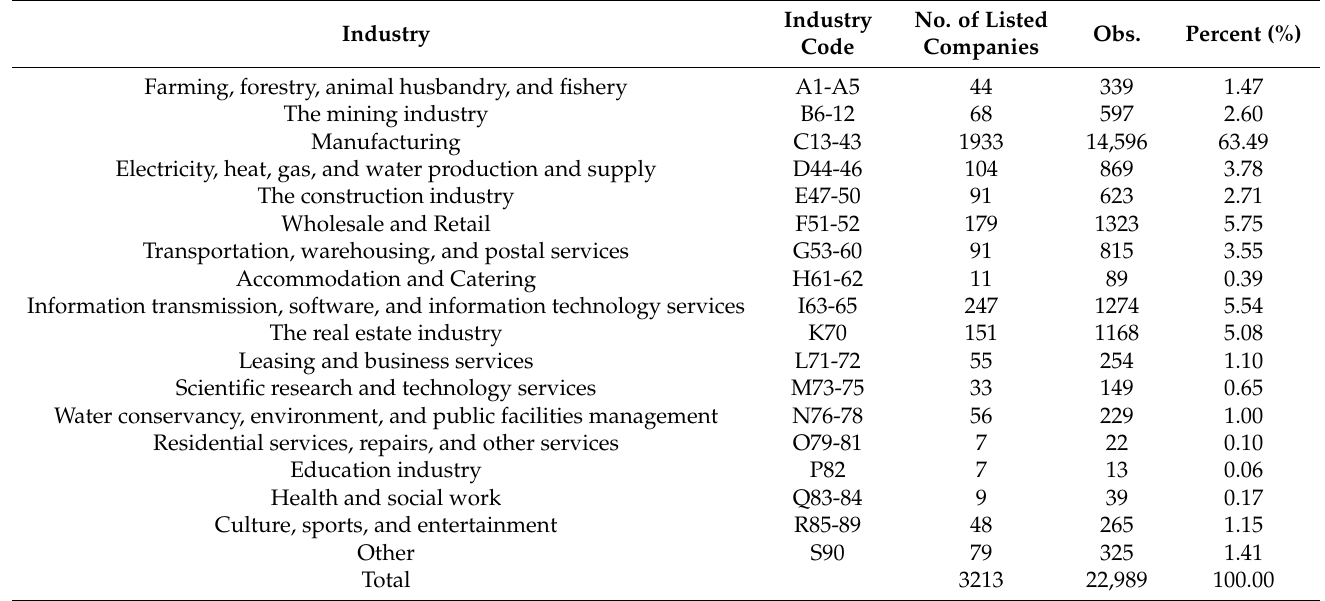
Table A1. Industry distribution and sampling firms.